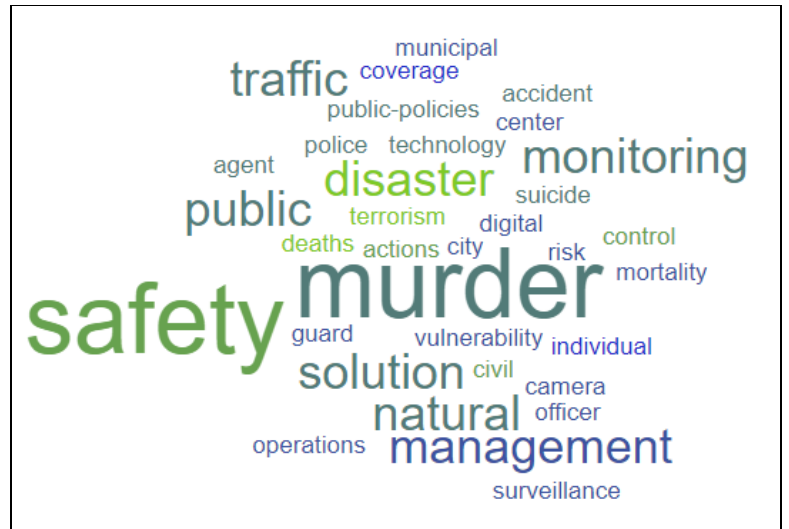
Figure 14. Most frequent indicators within the theme of “safety”.